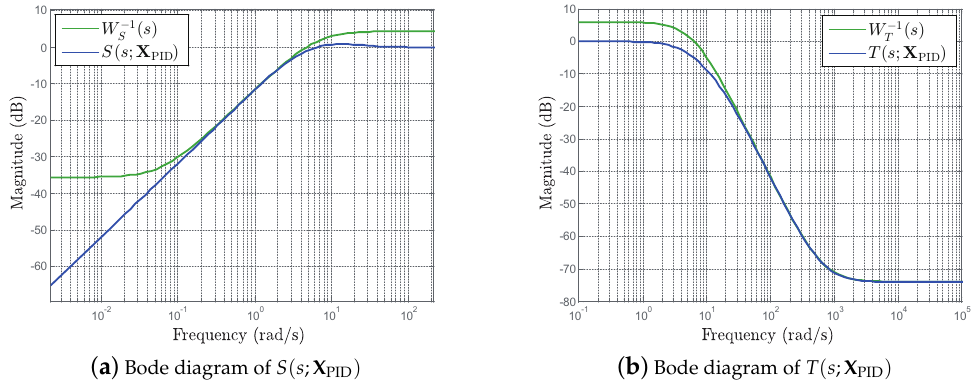
Figure 13. Frequency responses of sensitivity and complementary sensitivity